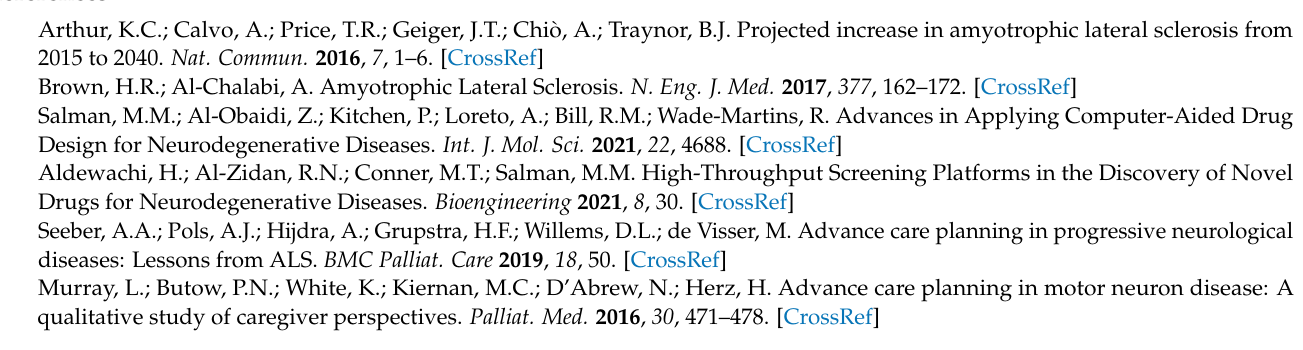
sample. Table S2: Characteristics of disease and wellbeing in different care settings, n =